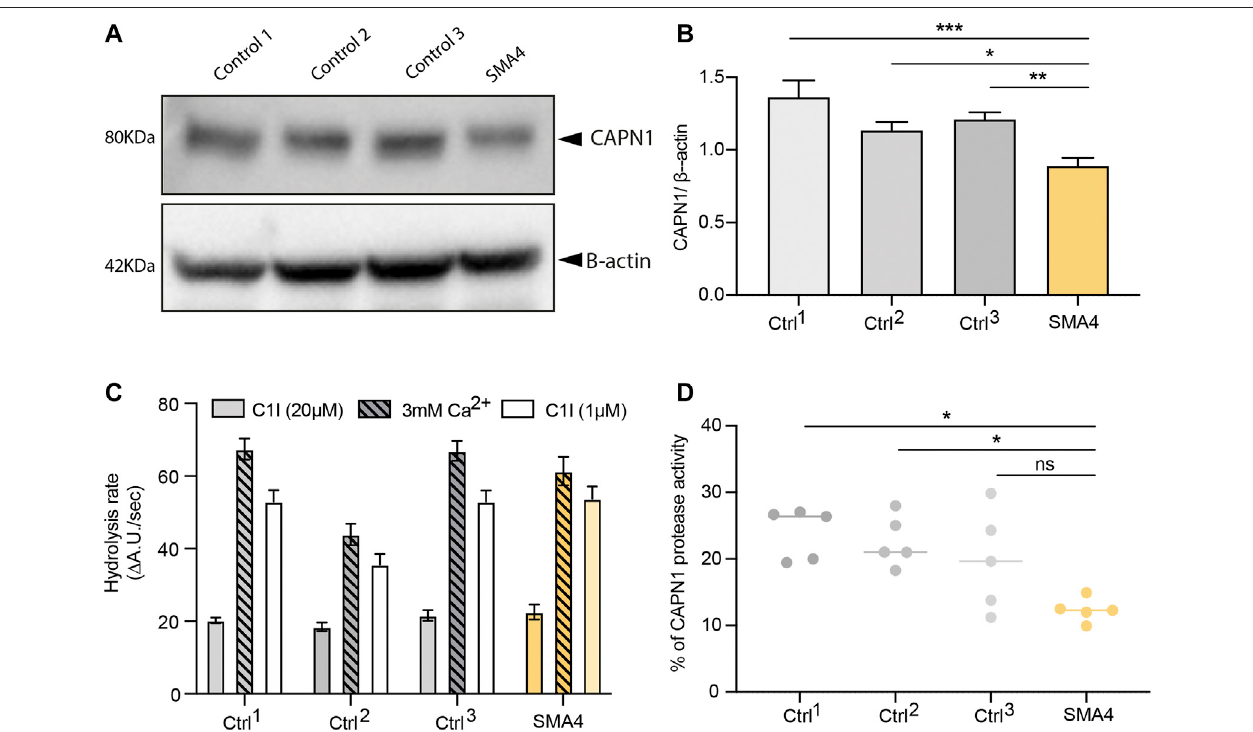
FIGURE2 | Consequences ofp.G492R/p. F610Ccompound heterozygous mutation on CAPN1 protein levels and protease activity. (A) Levelsof CAPN1 protein determined bywestern blotanalysisinlysates from aSMA4patient (proband II:2) compared tocontrols fi broblasts( n (cid:1) 3). β -actin wasused asaloading control inthese experiments. (B) Data in bar graphs are represented as mean ± SEM from 3 independent experiments. (C) Protease activity determined from 100 μ g protein lysates in the presence of 0.5 mM EGTA and 3 mM CaCl 2 (Ca 2+ ) , with and without the speci fi c calpain-1 inhibitor (C1I) at saturating (20 µM) and at half-maximal inhibitory concentration (1 µM). Data in bar graphs represents the mean ± SEM of the hydrolysis rate of 100 μ M Succ-LLVY-AMC substrate determined from the linear portion of the curve measured every 30 s for 45 min. (D) Calpain-1 activity from 5 independent experiments. Data is represented as % of Succ-LLVY-AMC hydrolysis in the assay thatcanbeattributed to CAPN1 ,calculatedbydividingthehydrolysisrateinthepresence of3 mMfreeCa 2+ bythevalueobtainedinthepresenceof1 µMC1I. p values were obtained from a 2-way ANOVA test (* p < 0.05; ** p < 0.005; *** p <